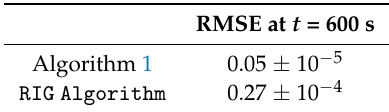
Table 3. RMSE at t = 600 s resulting after exploring scenario B. For this comparison Algorithm 1 employs Equations (6) and (7), and RIG Algorithm uses MI